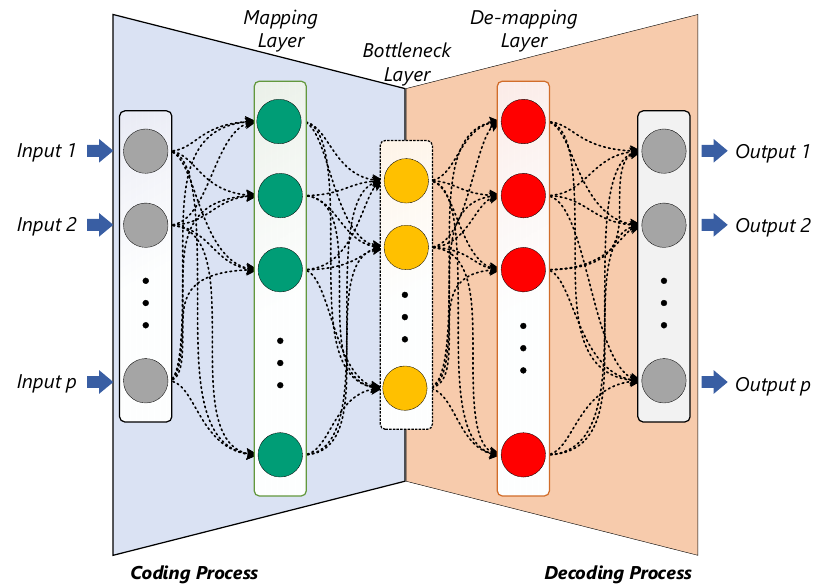
Figure 1. Graphical configuration of an auto ‐ associative neural network.